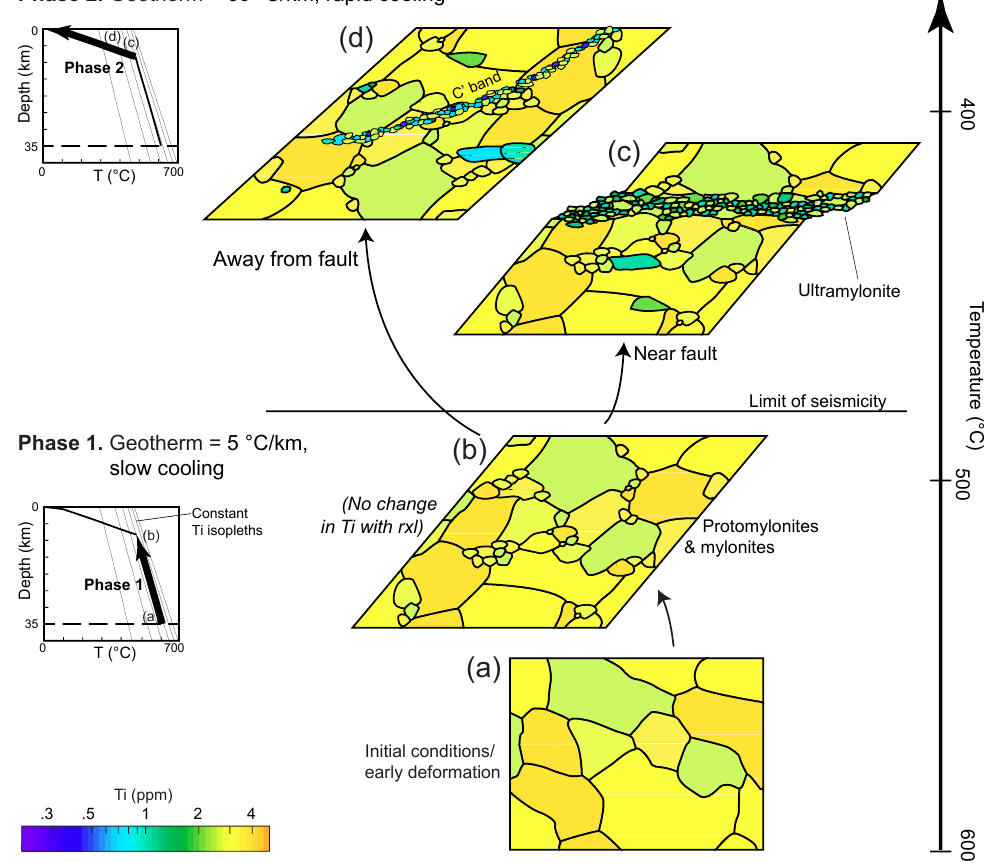
Figure 12. Simplified illustration of interpreted microstructural and Ti-in-quartz evolution. “Phase 1” deformation begins with Ti-in-quartz concentrations at 2–4ppm (a) . Strain associated with protomylonite and mylonite formation (b) involves recrystallization with no change in Ti-in-quartz concentrations due to exhumation along a constant-Ti isopleth (e.g., Fig. 11). During “phase 2,” newly recrystallized quartz grains tend to have lower Ti concentrations as a result of cooling along a much steeper segment of the geothermal gradient (Fig. 11). Near the fault (c) , ultramylonites form with Ti-in-quartz concentrations of 1–2ppm. The latest quartz recrystallization occurs away from the fault in protomylonites and mylonites in C (cid:48) bands (d) . Sporadic recrystallization of some medium-sized grains with Ti-in-quartz concentrations below 2ppm occurs in some rocks during phase